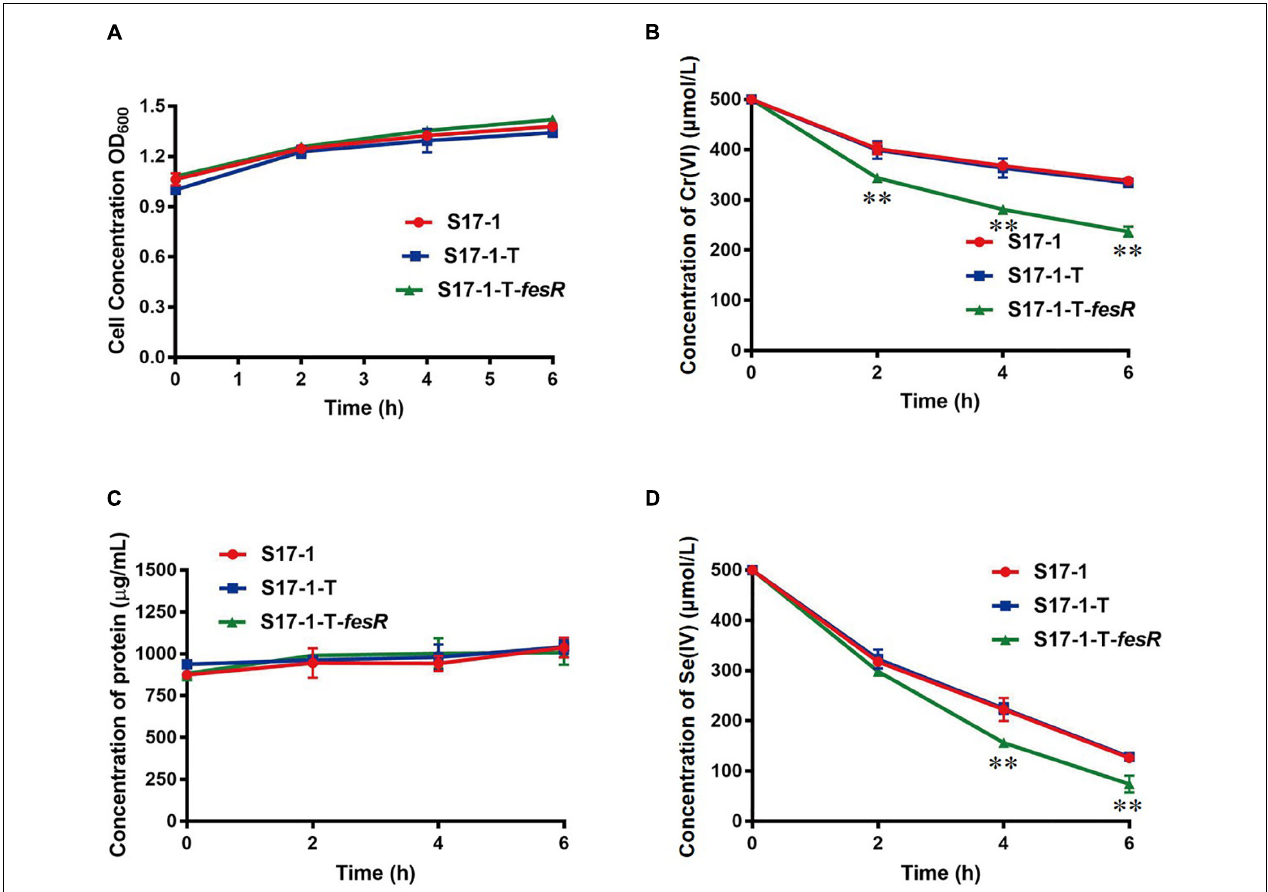
FIGURE 4 | FesR enhanced the Cr(VI) and Se(IV) reduction capacities of Escherichia coli Growth curves of E. coli S17-1, E. coli S17-1-T and E. coli S17-1-T- fesR in LB broth with 500 µ mol/L K 2 CrO 4 (A) and Na 2 SeO 3 (C) , respectively. Reduction curves of E. coli S17-1, E. coli S17-1-T and E. coli S17-1-T- fesR in Luria-Bertani (LB) broth with 500 µ mol/L K 2 CrO 4 (B) and Na 2 SeO 3 (D) , respectively. Data were expressed as mean ± SD of the biological three replicates. ∗∗ stands for the statistically highly significant as p < 0.001 between the overexpressed strain E. coli S17-1-T- fesR and control strains ( E. coli S17-1 and E. coli S17-1-T).